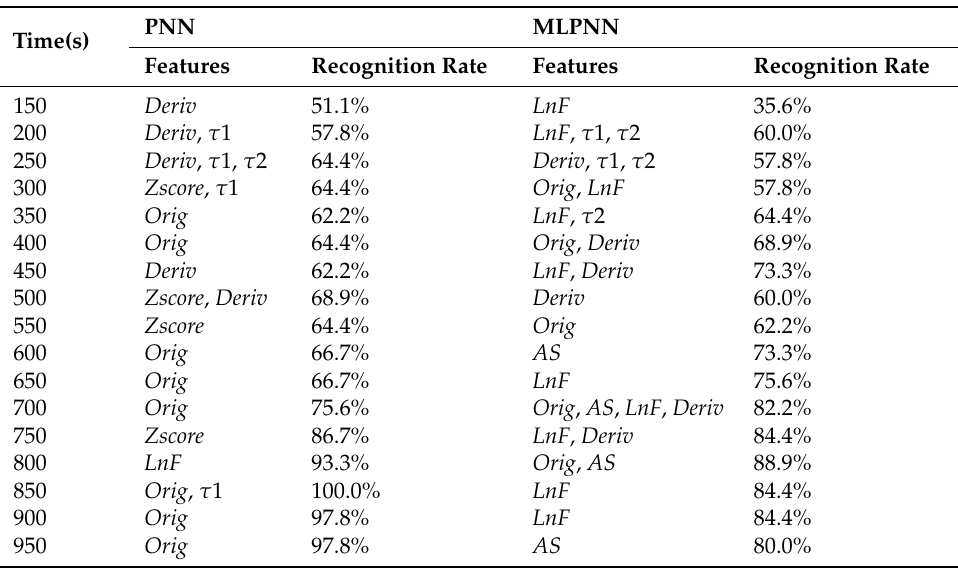
Table 3. Table detailing the features selected at time stations with their corresponding recognition rates obtained using sequential forward selection (SFS) based PNN and MLPNN